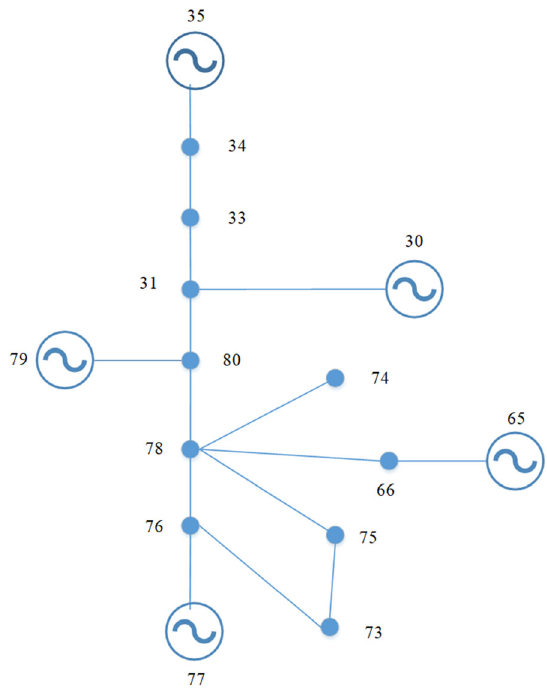
Fig. 6 Reduced WECC 179 bus 29 machine